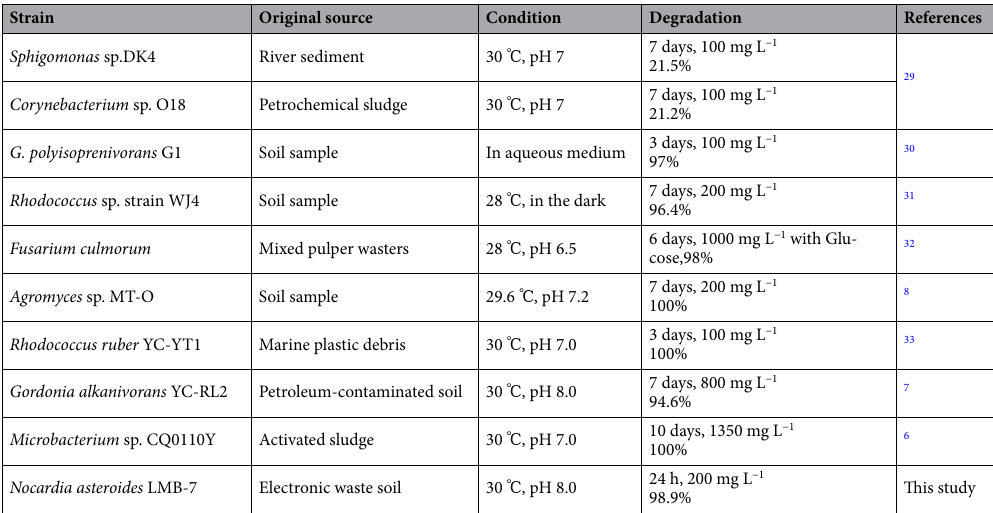
Strain Original source Condition